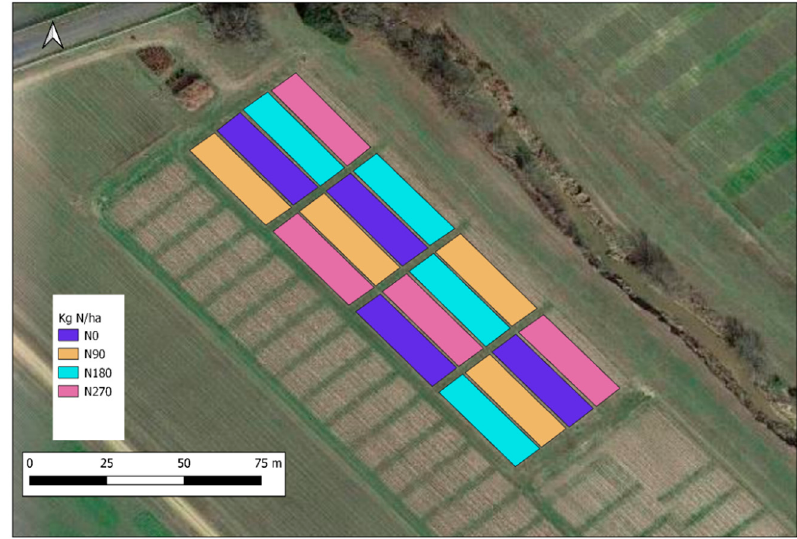
Figure 3. Nitrogen treatments and four replicates in 2017-2019 at the Research Farm, Mississippi State, US.